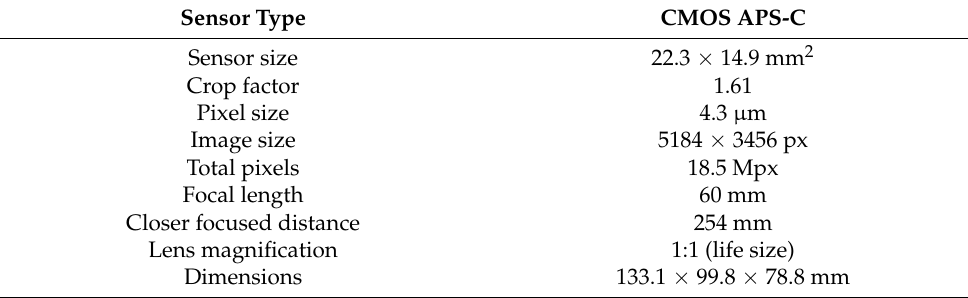
Figure 5. Data acquisition prototype: ( a ) platform of cameras and lighting units; ( b ) PLC and Quantum connections; and ( c ) single-line connection diagram. Table 4. Canon 700D with macrolens technical